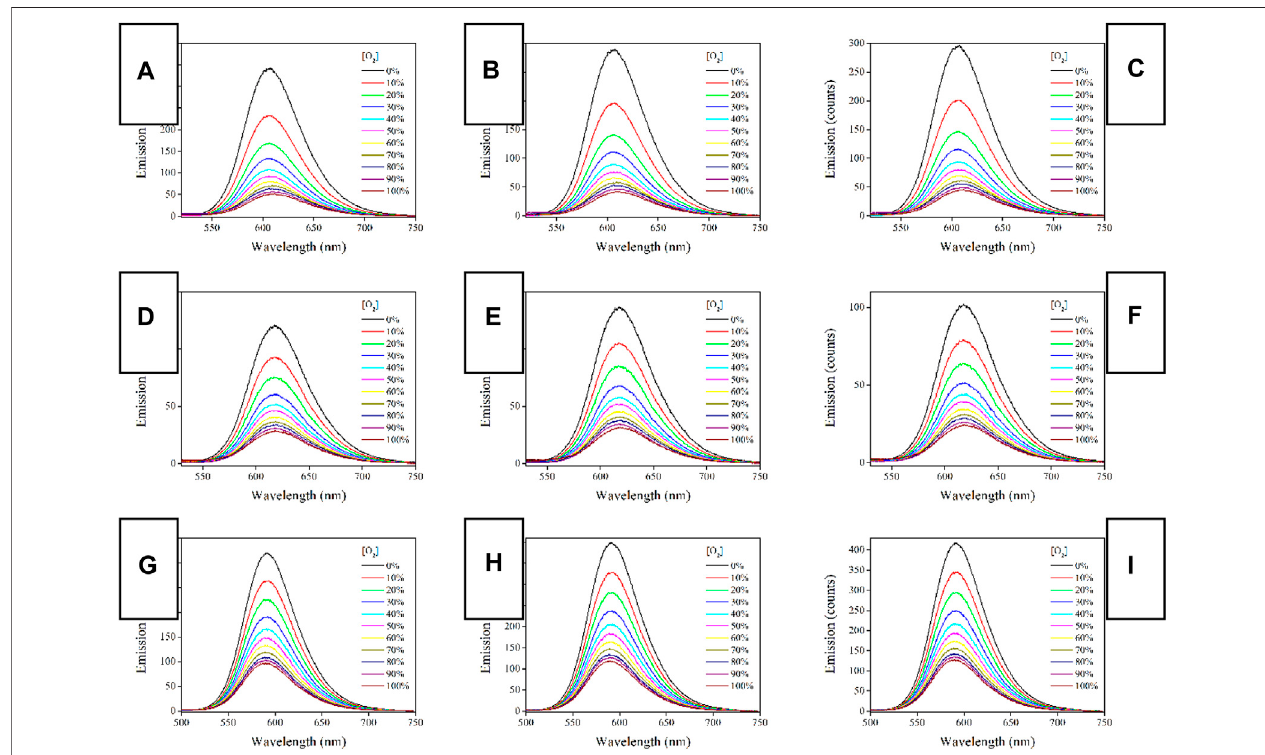
FIGURE 6 | Emission spectra of Ru-n@PS fi bers under increasing oxygen concentrations from 0 to 100%. (A) Ru-1@PS(10%), (B) Ru-1@PS(12%), (C) Ru-1@ PS(15%), (D) Ru-2@PS(10%), (E) Ru-2@PS(12%), (F) Ru-2@PS(15%), (G) Ru-3@PS(10%), (H) Ru-3@PS(12%), and (I) Ru-1@PS(15%).